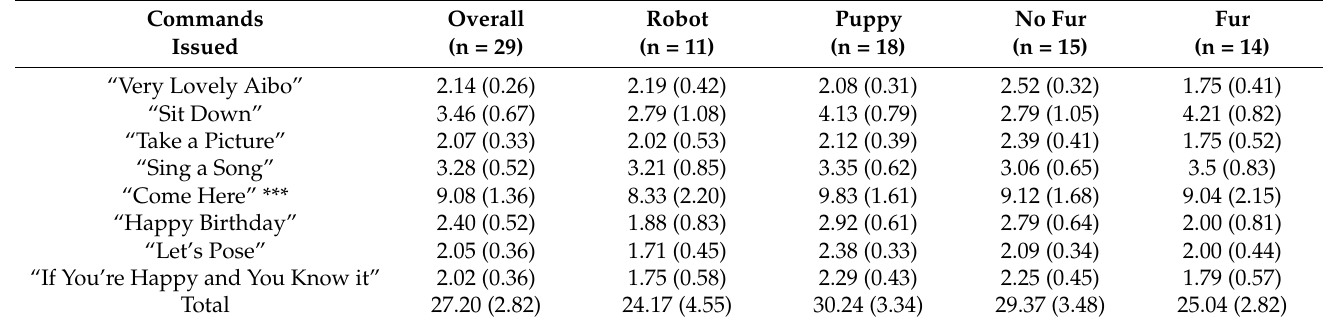
Table 3. Commands issued totals per command types, and per framing and appearance